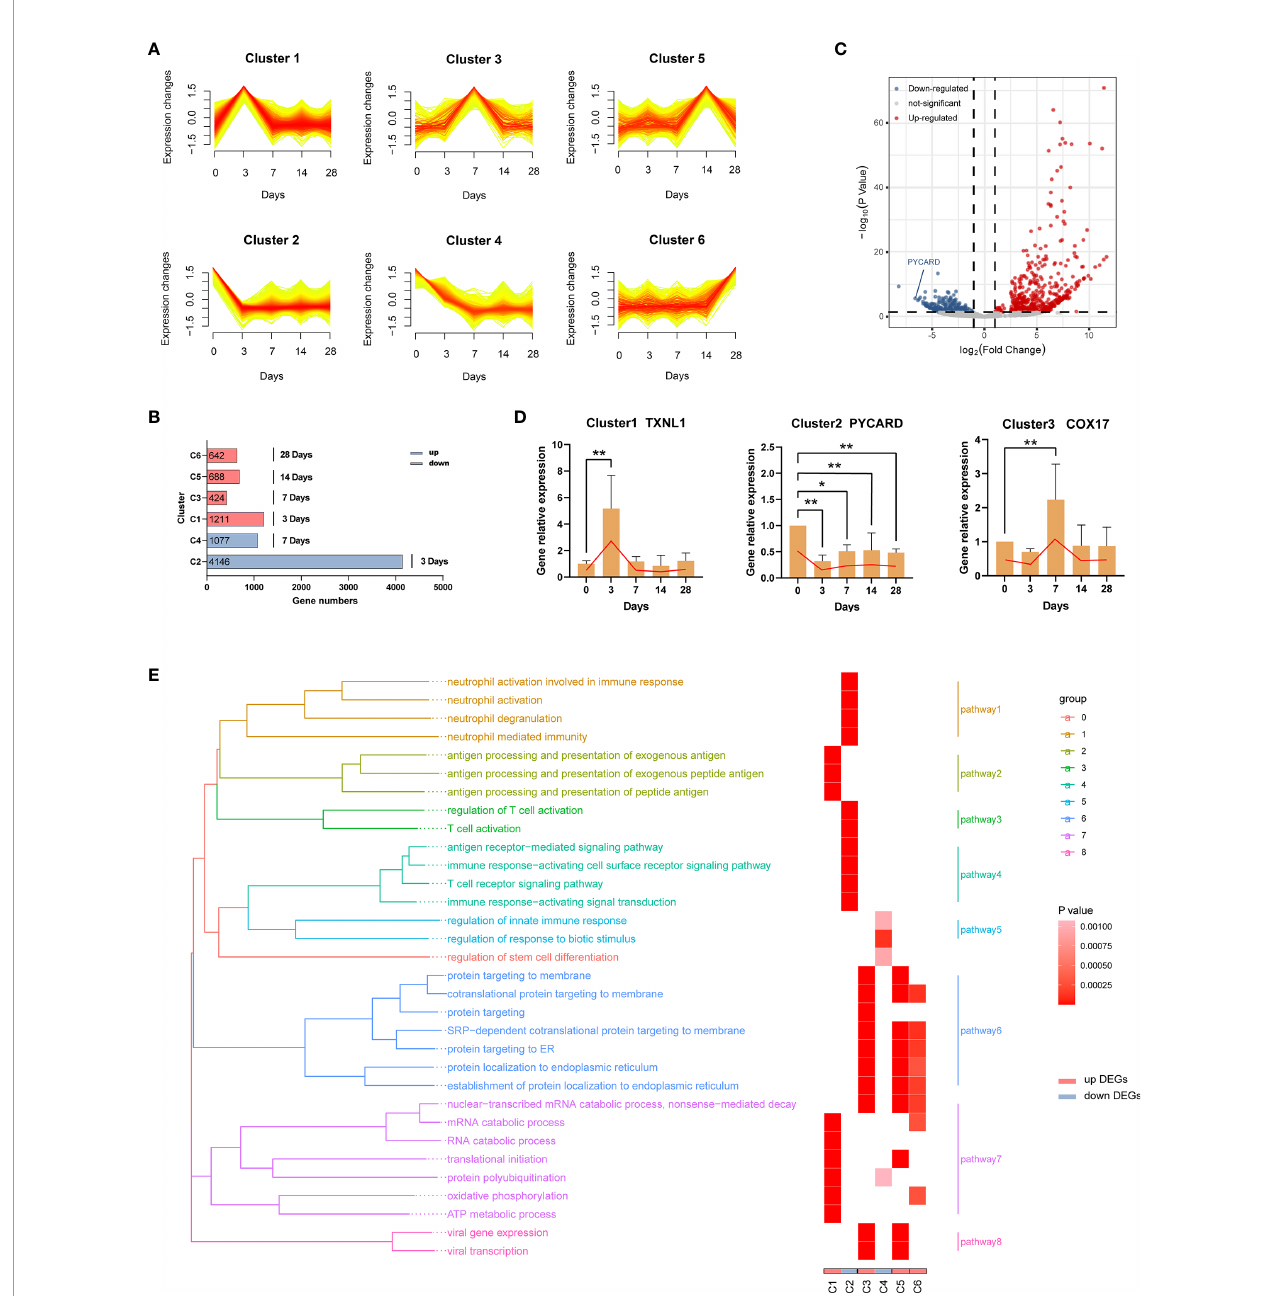
FIGURE 6 | Dynamic transcriptome changes induced by EBV infection. (A) Mfuzz clustering identi fi ed six distinct temporal patterns of genes expression according to expression pro fi les. The X-axis represents fi ve-time points, while the Y-axis represents log2-transformed, normalized intensity ratios in each time point. (B) The number of genes in each cluster. Genes in each cluster were classi fi ed as characteristic genes at four time points after EBV infection according to expression pattern. (C) The volcano plot of 3 dpi vs 0 dpi DEGs. (D) Validation of RNA-Seq results using RT-qPCR (TXNL1, PYCARD, COX17). Twelve genes (two genes per cluster) are shown in Supplementary Figure 2 . (E) Gene Ontology (GO) enrichment analysis of DEGs in each cluster; GO categories were collapsed into 8 pathways according to GO-term similarities by GOSemSim package. *p < 0.05, **p <